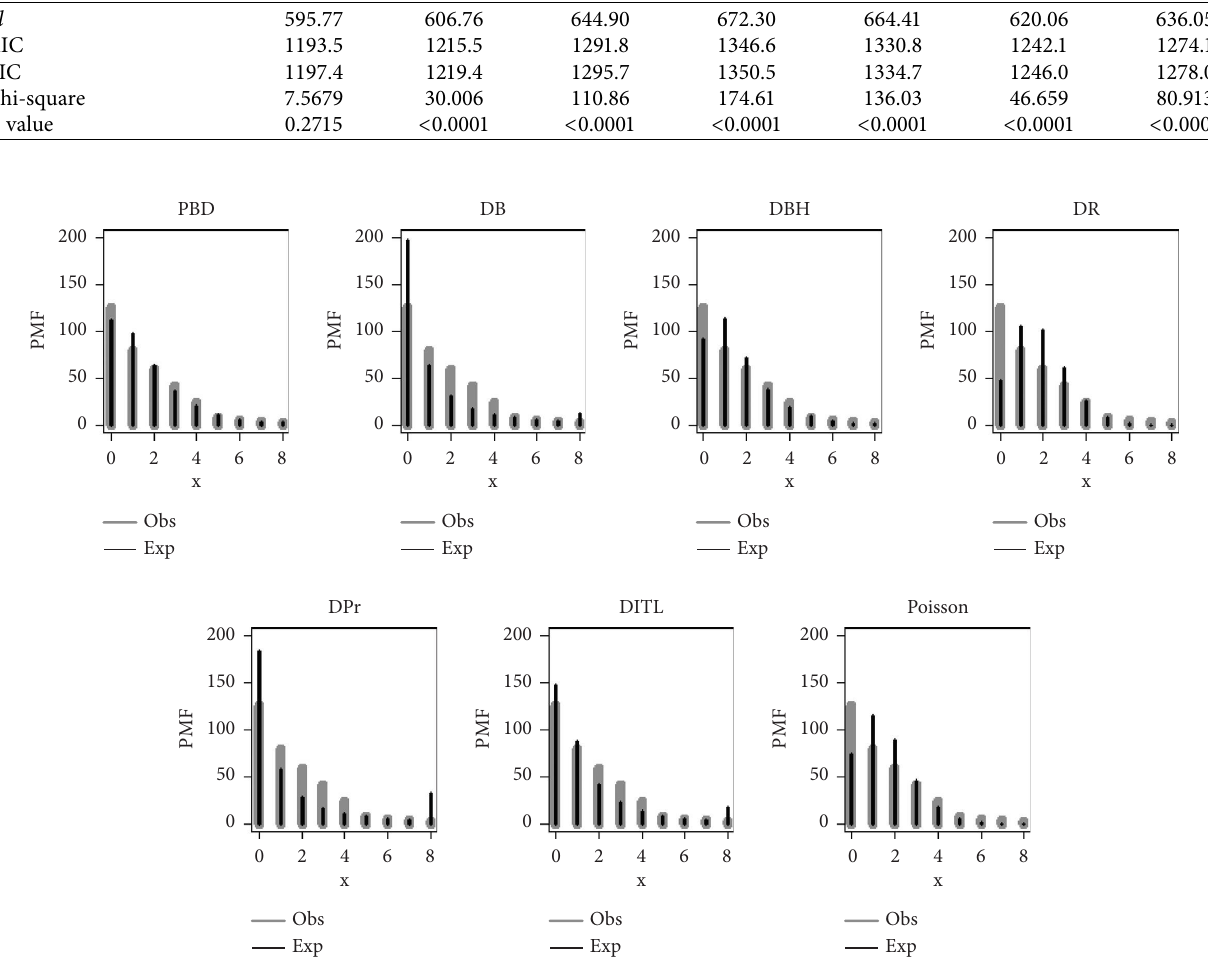
Figure 8: Te ftted PMF for data set